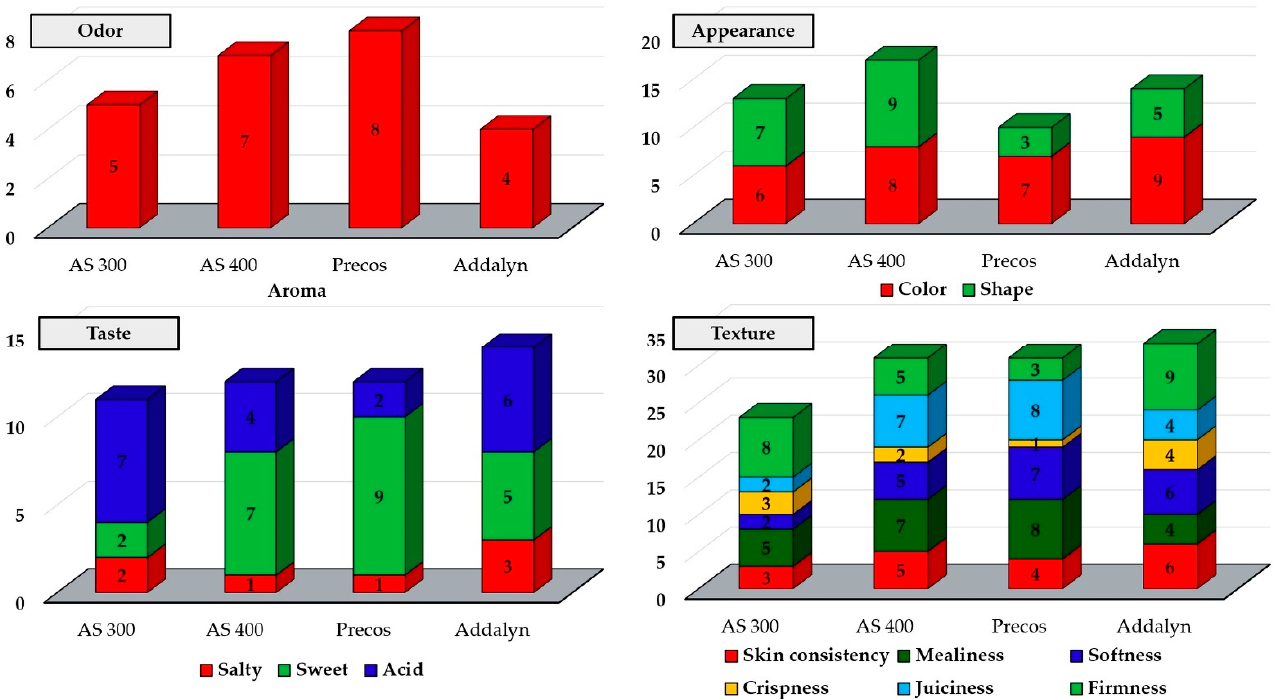
Figure 5. Rounded average values for the main organoleptic characteristics of tomato fruits, following evaluations attended by 60 tasters (30 women and 30 men). The evaluations were performed by completing questionnaires, using a hedonic scale with grades from 1 (‘Extremely dislike’) to 9 (‘Extremely pleasant’) for the overall preference of sensory attributes. The evaluation, also based on the 12 sensory descriptors, framed in four distinct attributes, was performed according to Vindras et al. [37]. Due to the lack of significant differences between women and men, the aggregated results are presented.